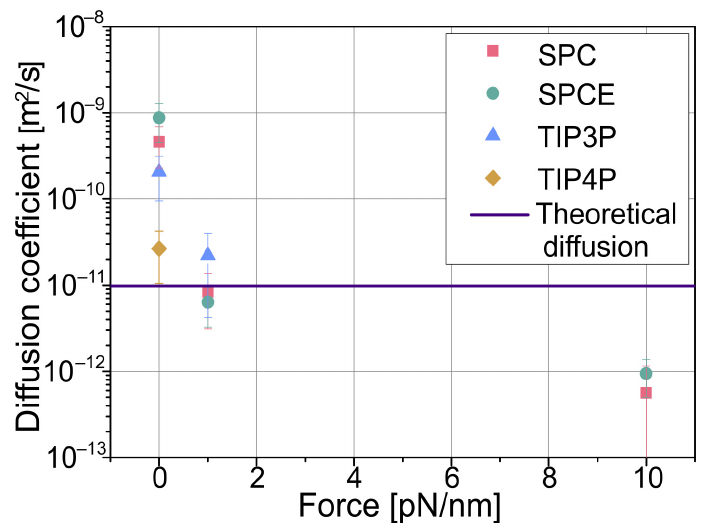
Figure 3. Calculated average diffusion coefficients obtained from simulation data. For the given colloidal particle, the theoretical diffusion coefficient without external force, calculated using the Stokes–Einstein equation, is 9.81 × 10 − 12 m 2 /s.